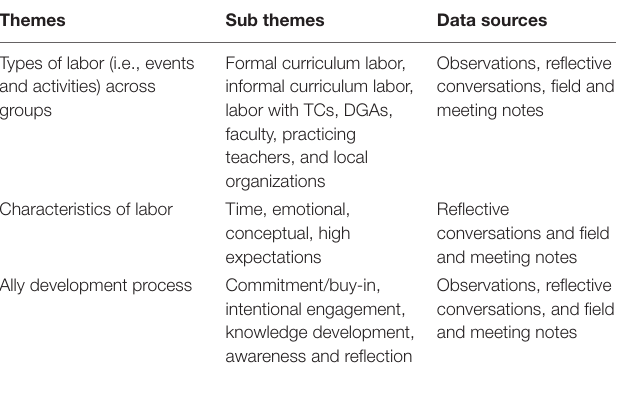
TABLE 3 | Coding and data